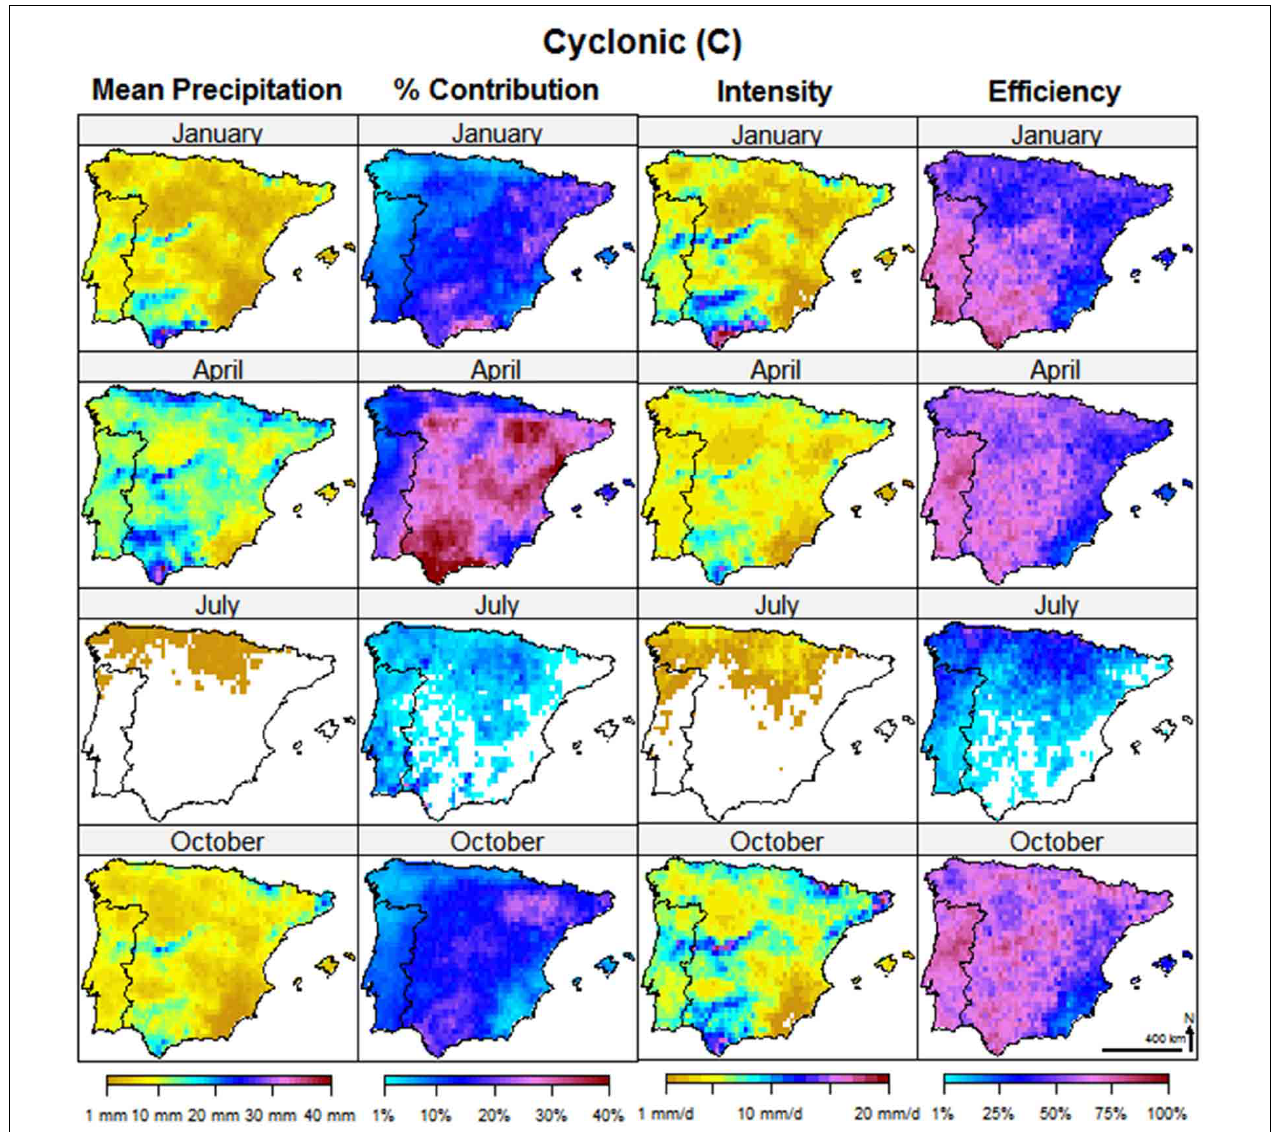
FIGURE 6 | As Figure 5 but relative to the Cyclonic (C)